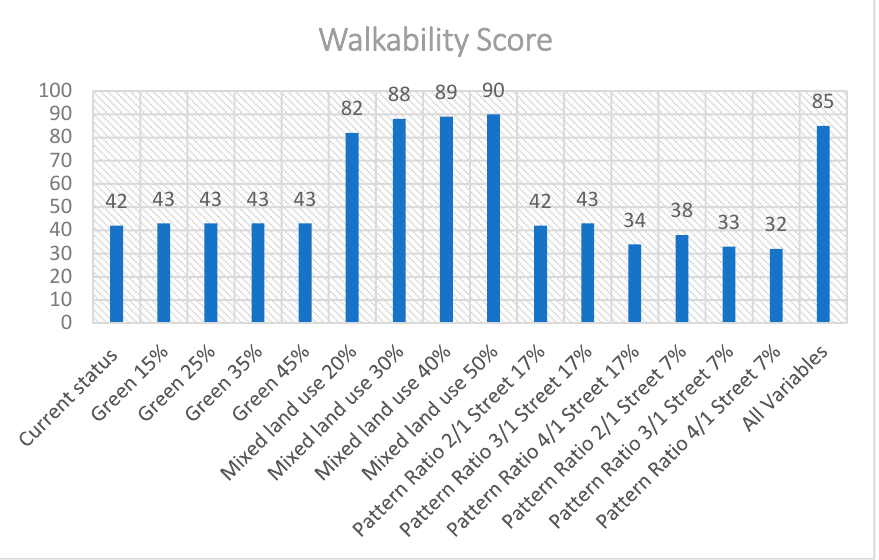
Figure 5. The walkability results for the various scenarios. Source: Designed by the researchers according to the previous simulation results.